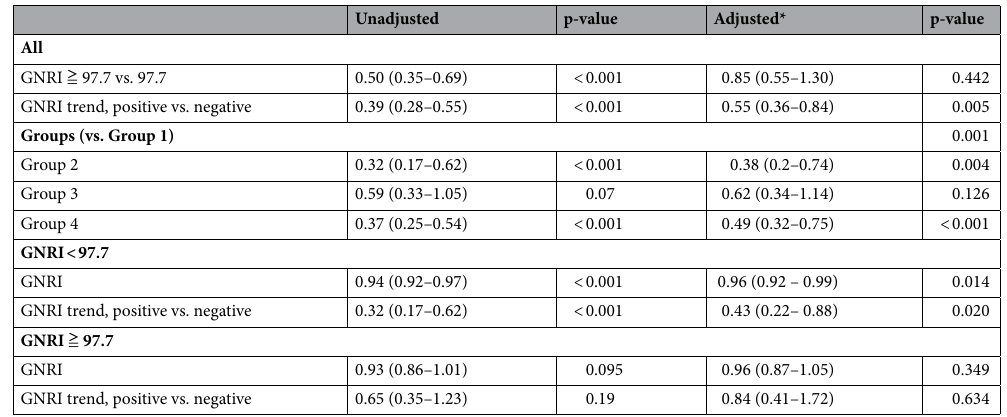
Table 3. Cox-proportional hazard ratios (95% confidence intervals) for all-cause mortality. GNRI geriatric nutrition risk index. *Adjusted for age, sex, primary causes of ESRD, the presence of coronary artery disease, heart failure, arrhythmia, cerebrovascular disease, chronic pulmonary disease, liver disease, gastrointestinal disease, systolic blood pressure, diastolic blood pressure, Kt/V and laboratory findings (hemoglobin, calcium phosphorus and